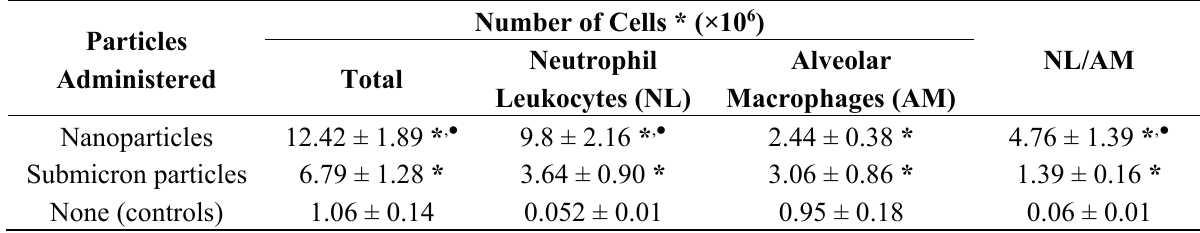
Table 1. Number of cells in the bronchoalveolar lavage fluid (BALF) 24 h after the intratracheal instillation of 1 mL suspension of copper-containing particles to rats at a dose of 0.5 mg per rat ( x ± S x